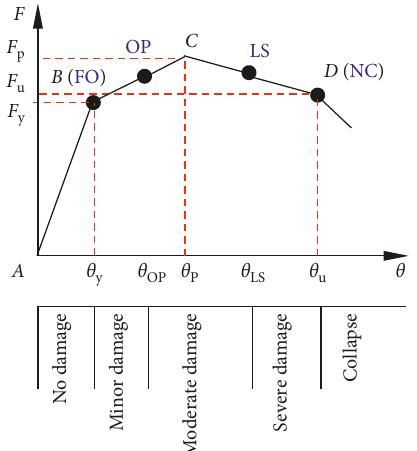
Figure 11: Backbone load-drift quantization model.